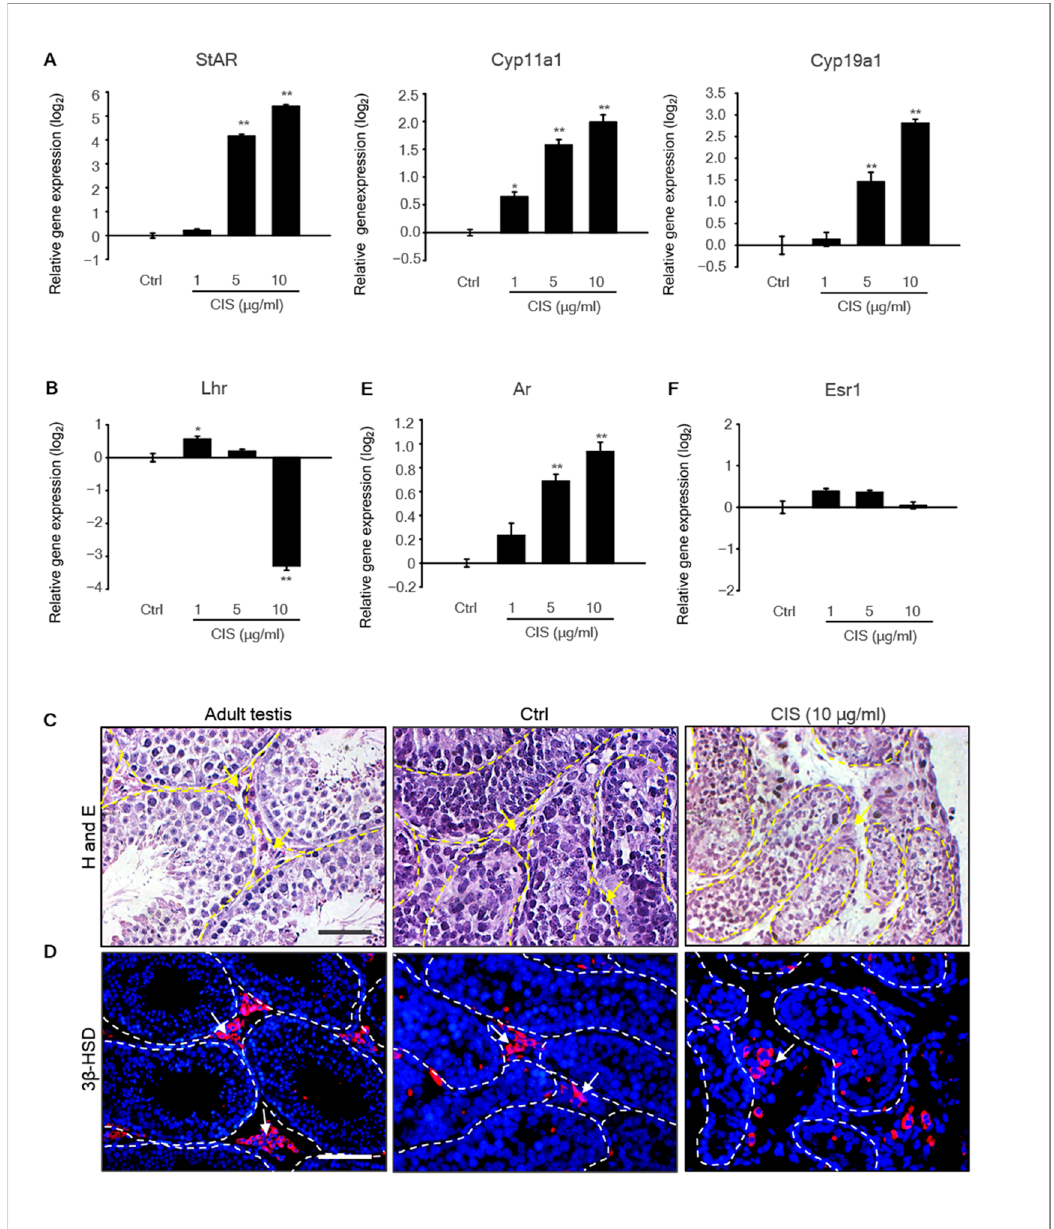
Figure 4. Expression of the steroidogenic marker in the MTF after cisplatin treatment. ( A ) The expression levels of the steroidogenic marker genes Star , Cyp11 α 1 , and Cyp19a1 and the expression levels of hormone receptors ( B ) Lhr, ( E ) Ar , and ( F ) Esr1 in cisplatin-treated MTFs were determined using qPCR. The relative quantification of mRNA expression is shown as the mean and the standard error of the mean ( n = 5) at the log 2 scale. * p < 0.05, ** p < 0.01. ( C ) The histological data revealed that Leydig cells were present in the interstitial region of MTFs exposed to cisplatin, non-treated MTFs, and adult testes (yellow arrowhead). ( D ) Steroidogenic marker, 3 β -HSD protein, was detected in cisplatin-treated (10 μ g/mL) and -untreated MTFs by immunostaining (white arrowhead). Scale bars = 50 μ m. All images were acquired at the same magnification.